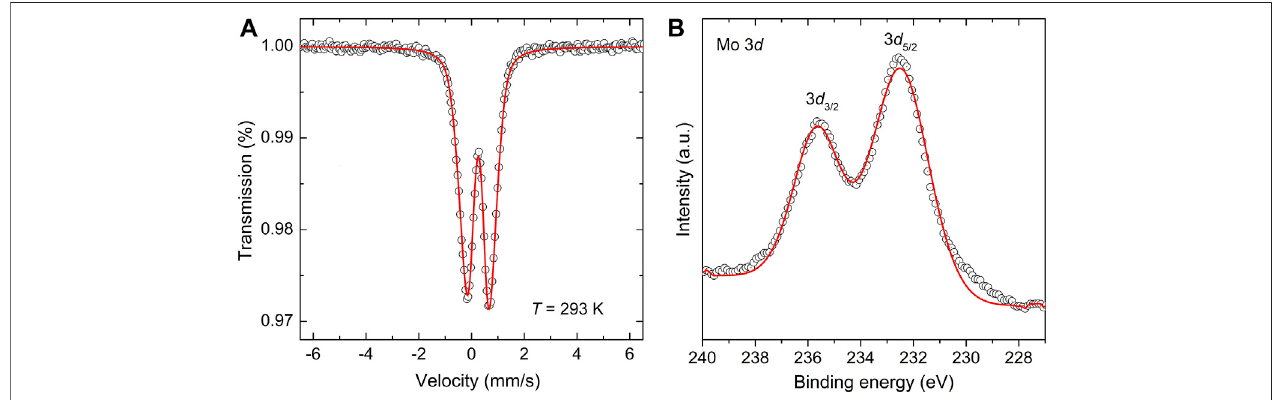
FIGURE 5 | (A) The room-temperature 57 Fe Mössbauer spectrum and (B) the Mo 3d core level XPS spectrum of the as-prepared Sr 2 FeMoO 6